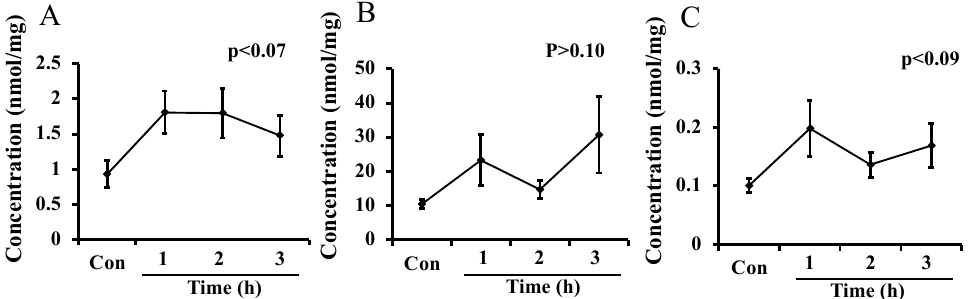
Figure 3. Putrescine ( A ), spermidine ( B ), and spermine ( C ) levels in milk after oral administration of L-ornithine in Experiment 3. Data are expressed as means ± SEM. n = 4–8/group. Con: control.